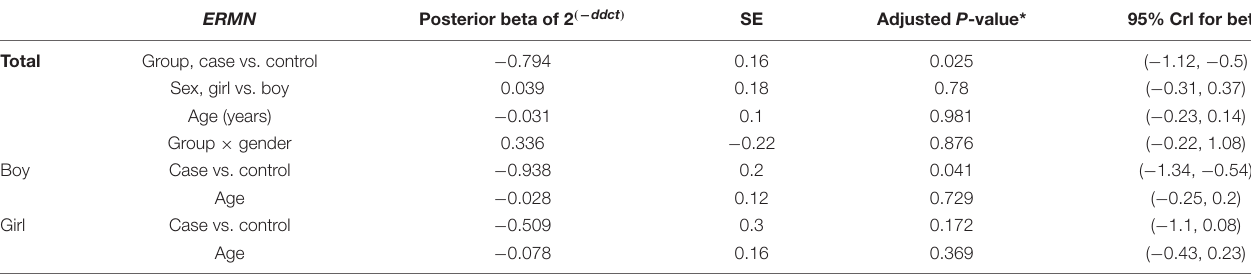
TABLE 3 | Relative levels of ERMN in ASD cases and controls according to the Bayesian quantile regression model. Posterior beta of 2 ( − ddct )